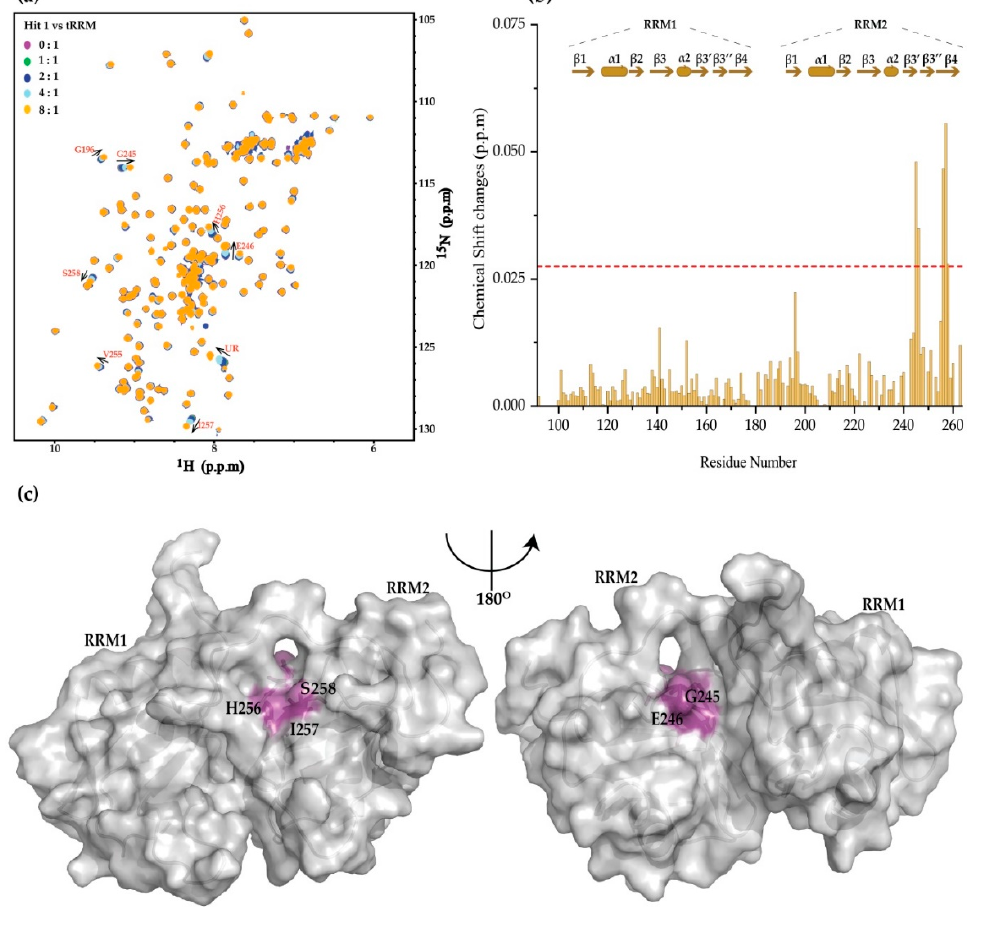
Figure 2. The binding topology of hit 1 on the tandem RRMs of TDP-43 using NMR chemical shift perturbations. ( a ) The chemical shift perturbations of 15 N-labeled tandem RRM domain of TDP-43 upon titration of hit 1. The ligand/protein molar ratios are annotated. The perturbed residues are labeled and the arrows indicate the direction of chemical shift changes. UR stands for unassigned residue. ( b ) Chemical shift changes of the TDP-43-tandem RRM domain are at the ligand protein molar ratio of 8:1. The red horizontal dashed line represents two standard deviations above the averaged chemical shift changes of residues. ( c ) Surface representation of TDP-43 tandem RRM domain (PDB code: 4BS2) showing the purple-colored residues with significant chemical shift changes.